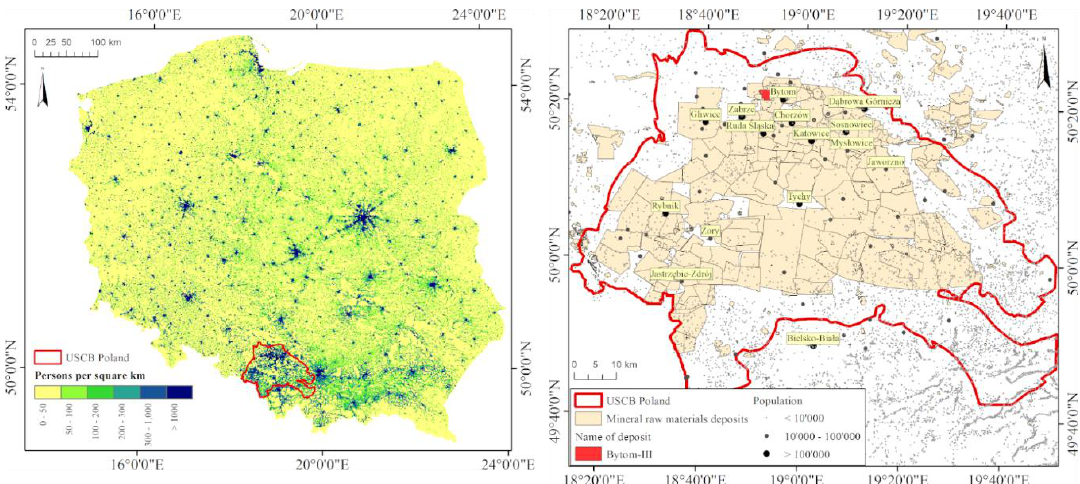
Figure 8. Population density in Poland for 2011 ( left ), according to the Central Statistical Office, and in the USCB ( right ).